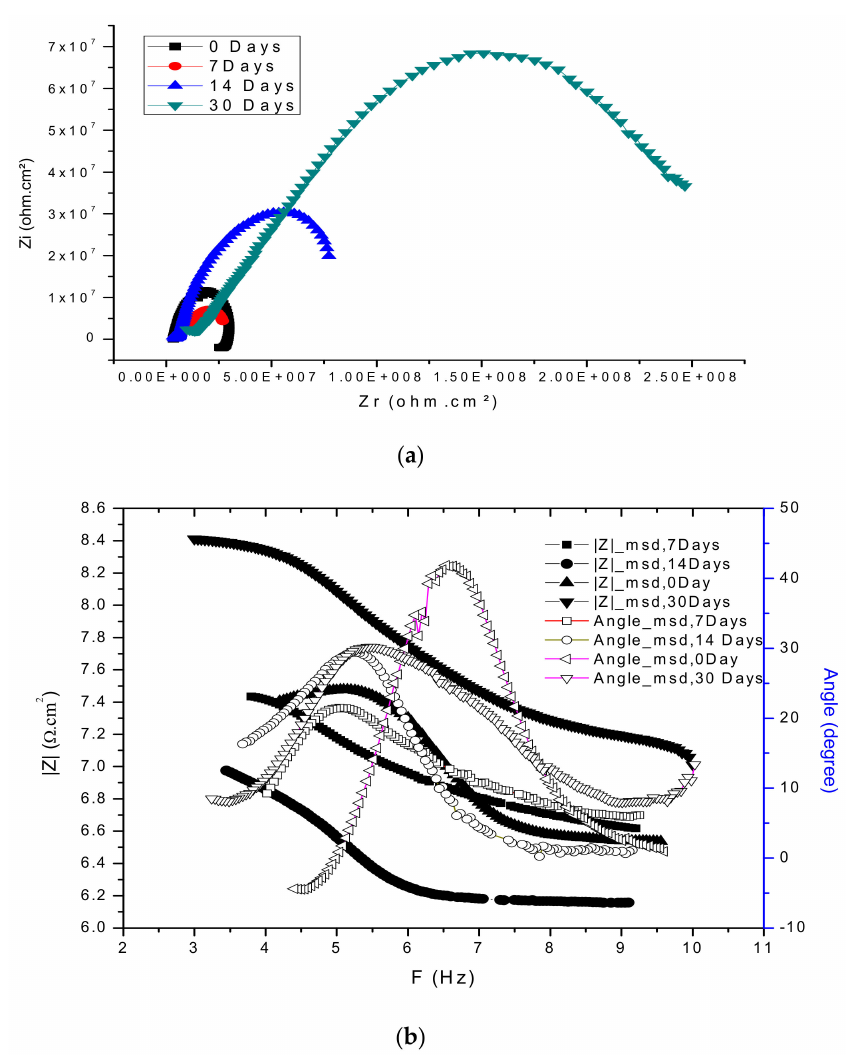
Figure 6. Electro impedance spectroscopy of the experimental alloy: ( a ) Nyquist; and ( b ) Bode